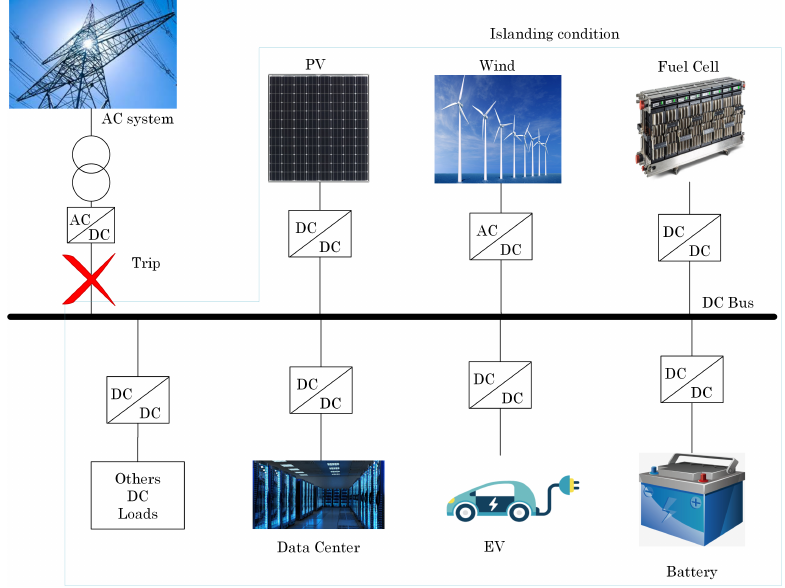
Figure 1. Typical DC system